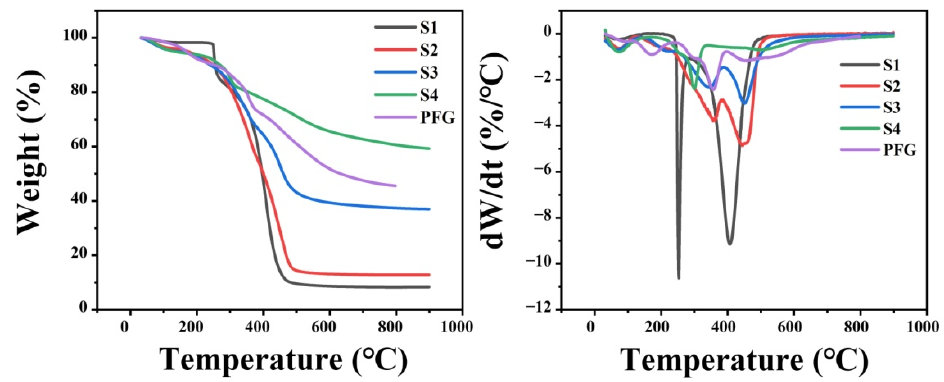
Figure 7. TGA and DTG curves of the different grinding wheels.